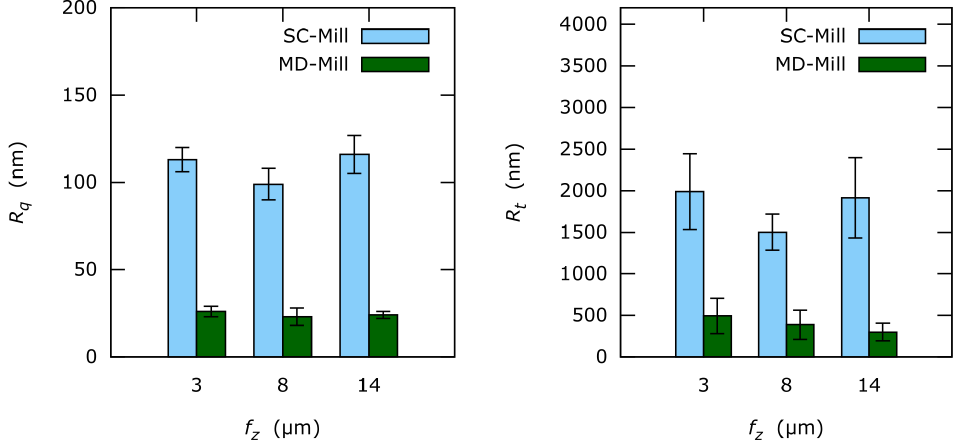
Figure 12. Horizontal one-dimensional roughness values R q and R t of the analyzed surfaces.